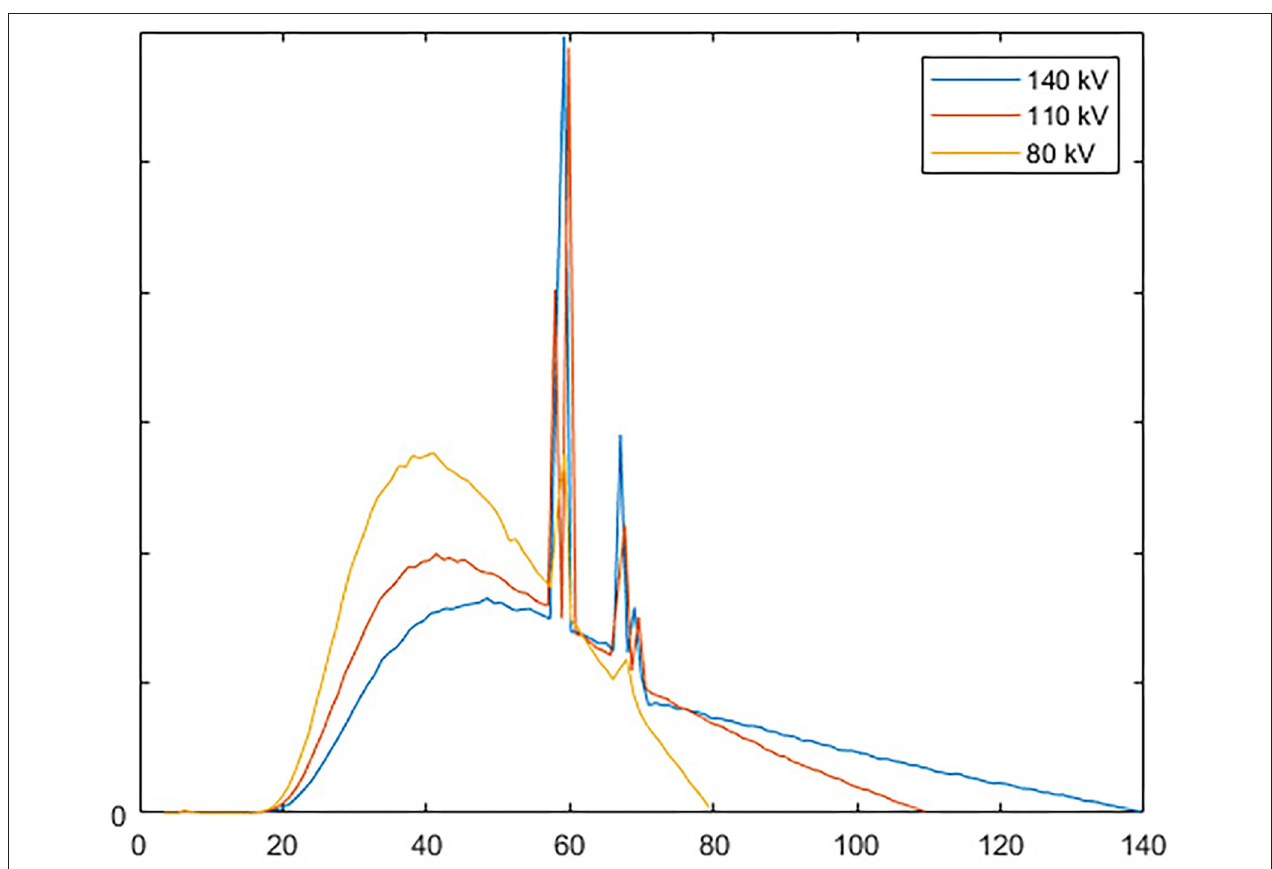
FIGURE 8 | The spectra of all three voltages. The intensities have been uniformed for each spectrum.